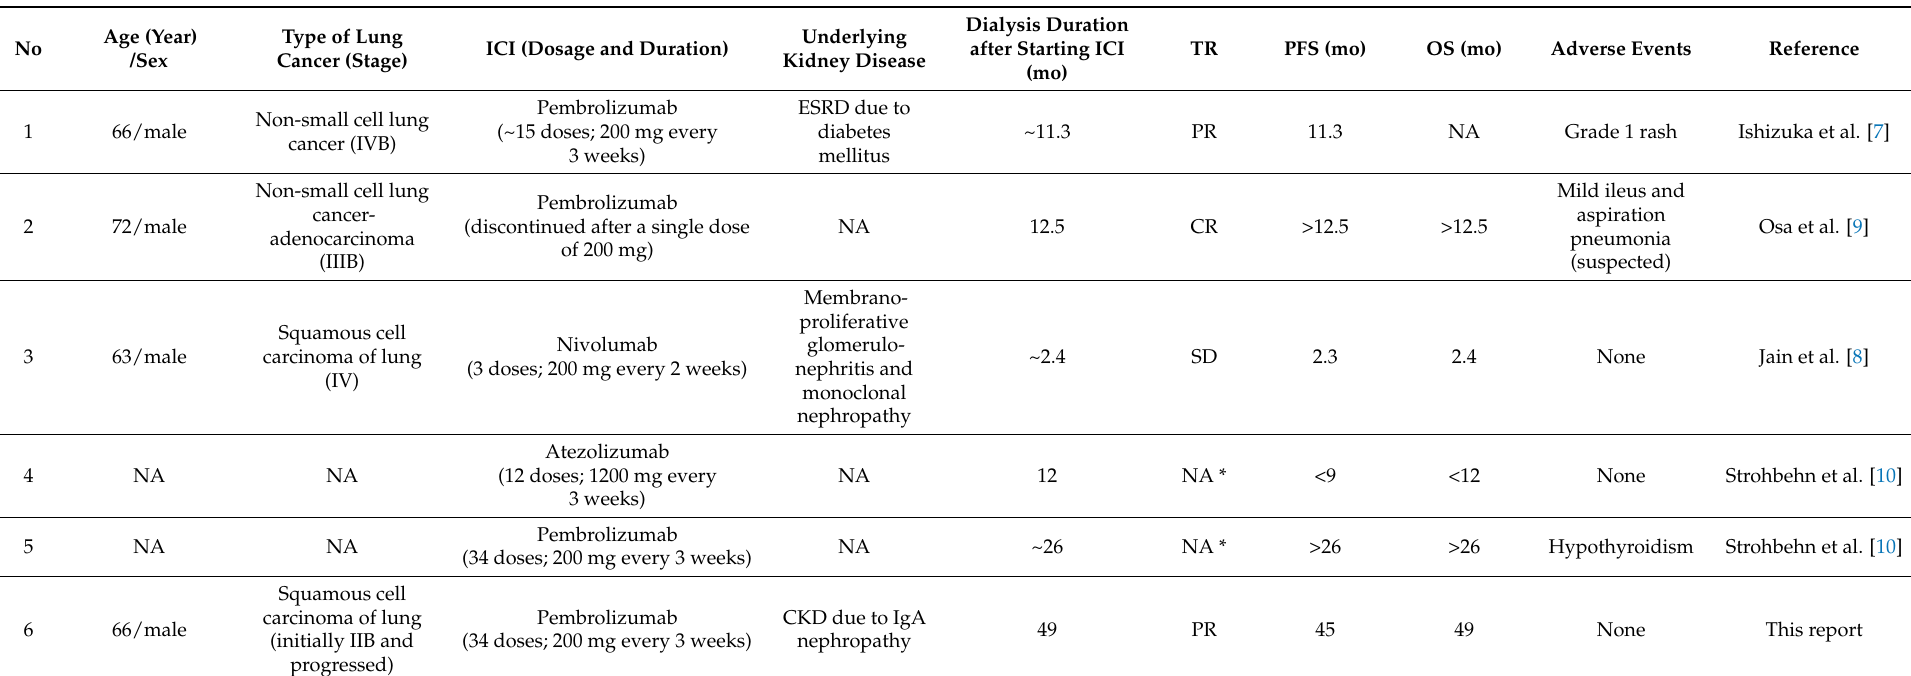
Table 1. Six lung cancer patients previously reported to have used ICI during